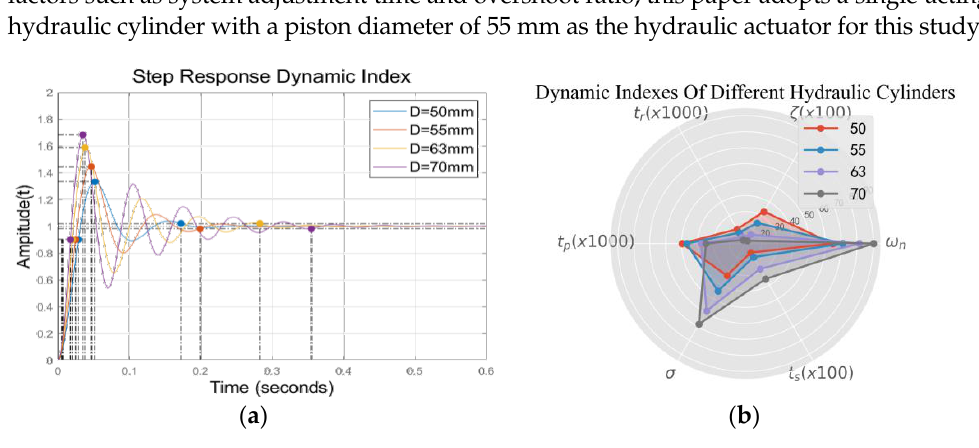
Figure 10. Comparison of multiple response indicators of different oil cylinders. ( a ) Step response index; ( b ) Parameter index radar distribution map. index; ( b ) Parameter index radar distribution